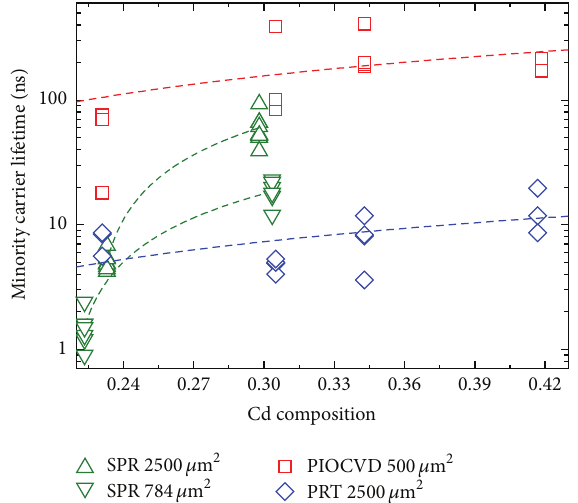
Figure 6: The variation of the extracted lifetime values with Cd composition using three experimental